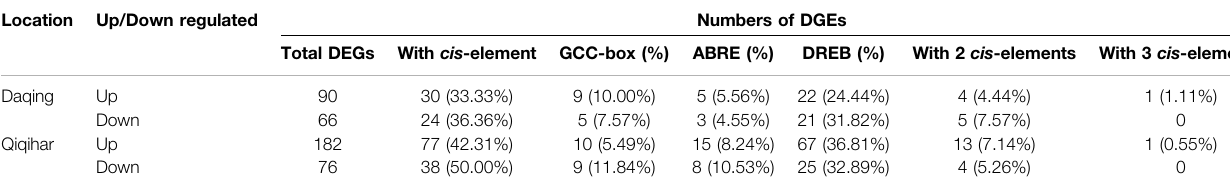
TABLE 1 | Types and numbers of cis-elements present in the promoter regions of the DGEs.